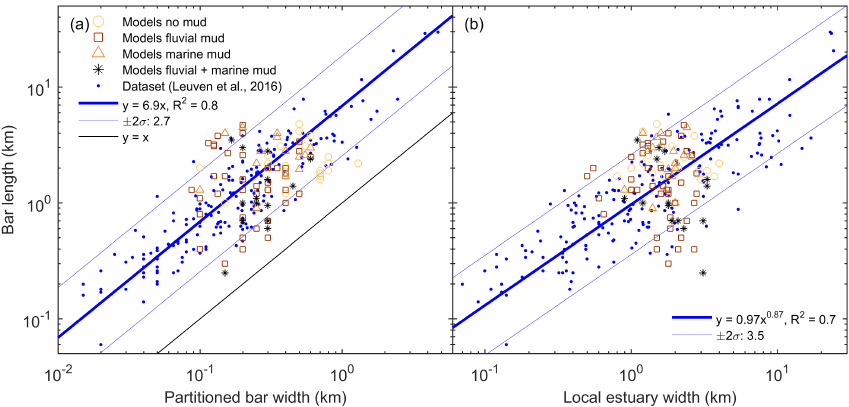
Figure 11. (a) Bar length versus partitioned bar width and (b) bar length against local estuary width. Model results plot in the same range as the data of the natural estuaries (Leuven et al.,